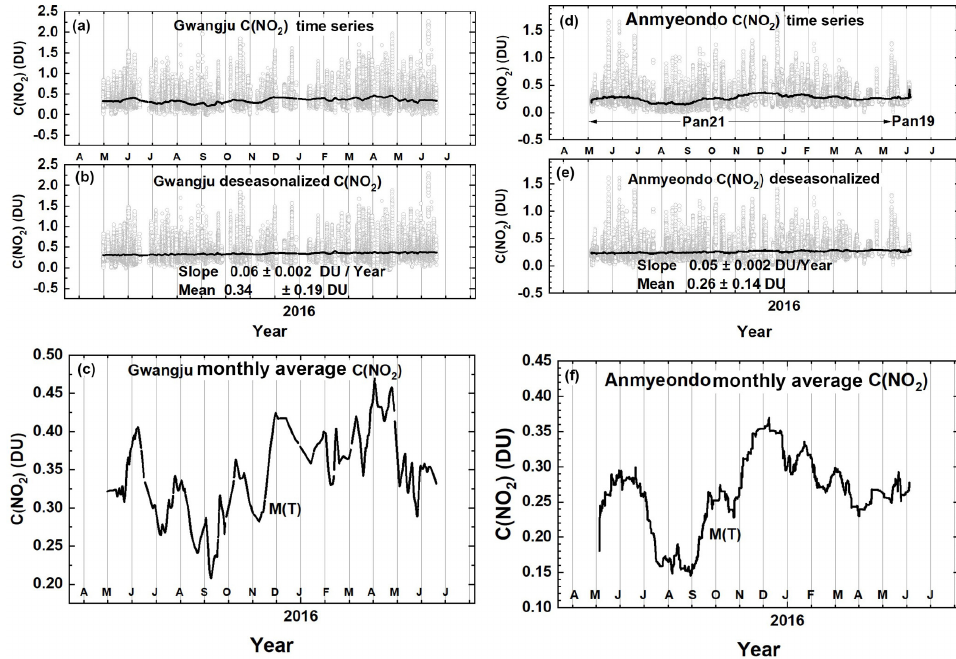
Figure 6. Approximately 1 year of daily column C ( NO 2 ) amount data (a, d) and the monthly running average amount (dark plot in panels a and d ). The data are from GIST at Gwangju and Amnyeondo. Panels (a) and (d) are the original time series with one data point every 80s, panels (b) and (e) are the deseasonalized time series. Panels (c) and (f) are an expanded scale of the monthly running averages M(t) of C ( NO 2 ) that are identical to the solid lines in panels (a) and (d) . The vertical extent (a, b, d, e) on a given day is the range of diurnal variation from early morning to late afternoon.